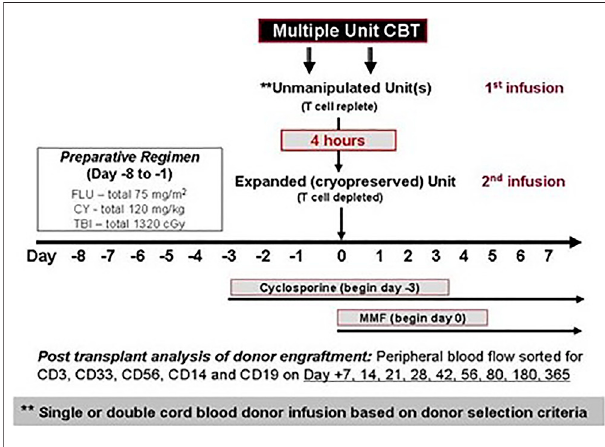
FIGURE 1 | Treatment plan.